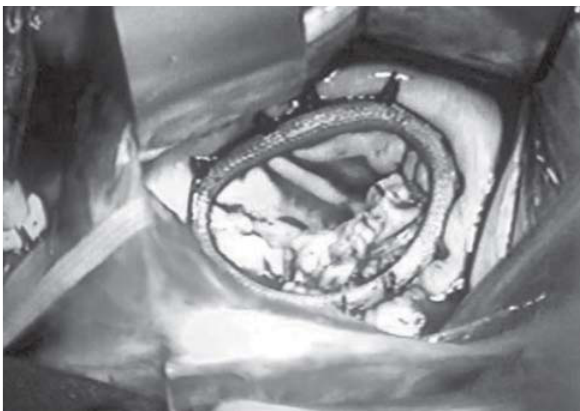
Fig. 4 – Colocação de um anel de Carpentier, usado em casos